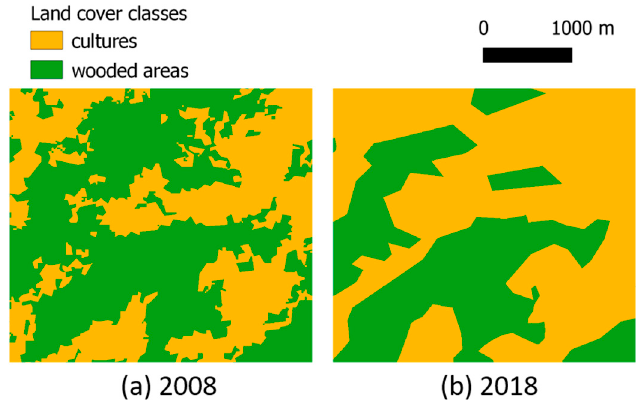
Figure 11. A detail of the land use/land cover map from 2008 with object-oriented method ( a ) and from 2018 with photointerpretation ( b ). In addition to the difference of wooded areas surface, edges appear coarser on ( a ), while on ( b ), patches are more compact, with shorter edges.